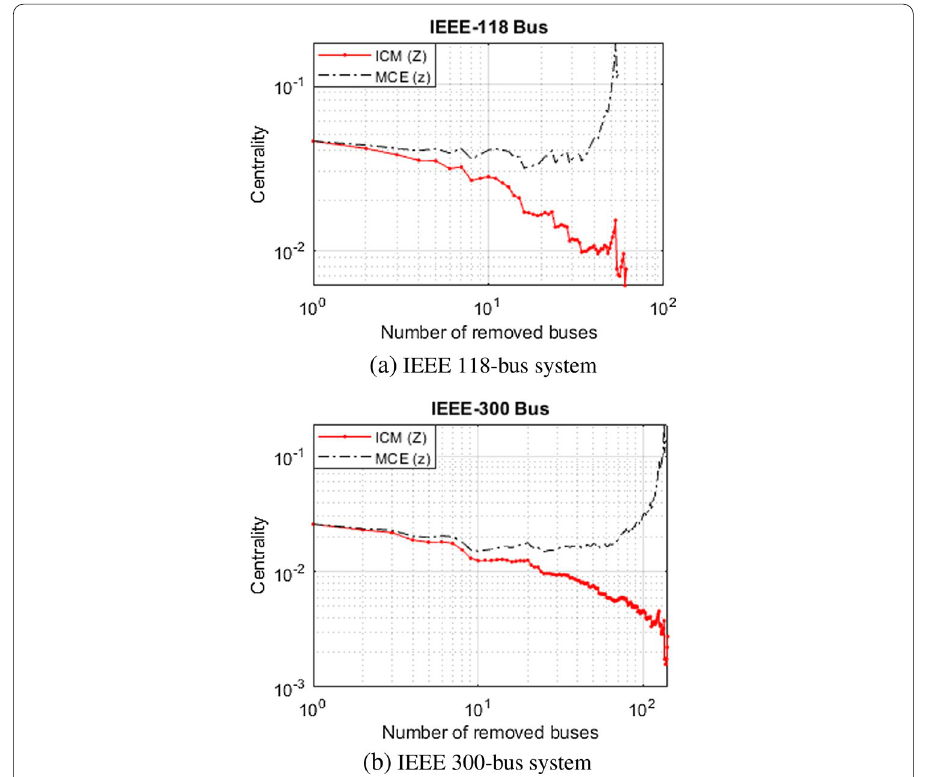
Fig. 3 Logarithm of degree centrality with basis on ICM (red) and MCE